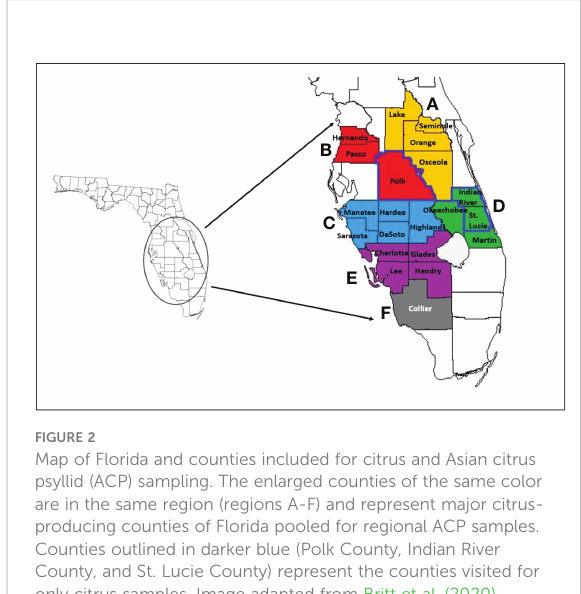
FIGURE 2 Map of Florida and counties included for citrus and Asian citrus psyllid (ACP) sampling. The enlarged counties of the same color are in the same region (regions A-F) and represent major citrus- producing counties of Florida pooled for regional ACP samples. Counties outlined in darker blue (Polk County, Indian River County, and St. Lucie County) represent the counties visited for only citrus samples. Image adapted from Britt et al.